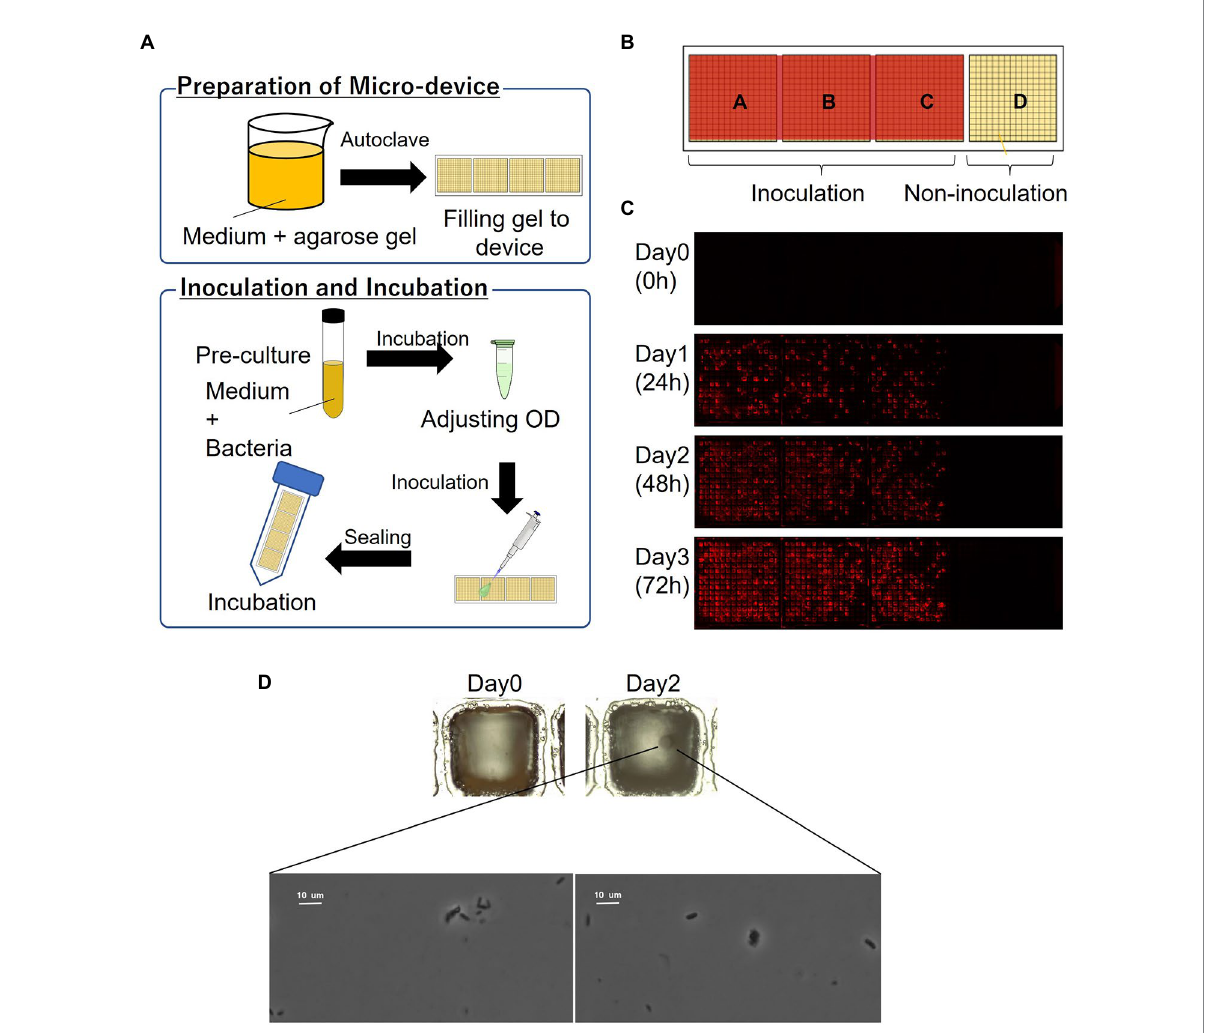
FIGURE 2 Culturing microorganisms in the gel-filled microwell array device. (A) Schematics of the culturing procedure using the device. (B) Arrangement of inoculation area on the device. (C) Micrographs of a gel-filled well just after inoculation to after 72 h of incubation. (D) Bacterial colony and bacterial cells from marine hydrocarbon-contaminated sediments obtained using gel-filled microwell array device. Microscopic observation of bacterial colonies (top; magnification ×100) and bacterial cells (down; magnification